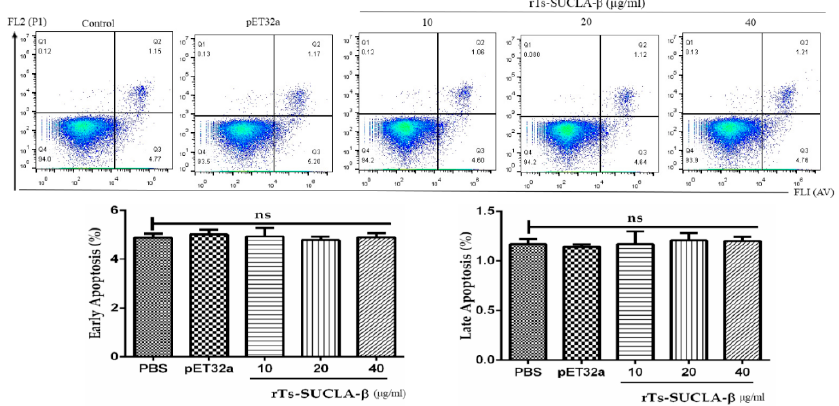
Figure 7. Effects of rTs-SUCLA- β on early and late apoptosis in PBMCs. Apoptosis of PBMCs was determined by flow cytometry after cells stained with Annexin V and propidium iodide. The percentages of cells with different staining patterns are shown in data statistics on the apoptosis of rat PBMCs (Q3 region of early apoptosis and Q2 region of advanced apoptosis). The data presented here are expressed as standard error mean of three independent experiments.